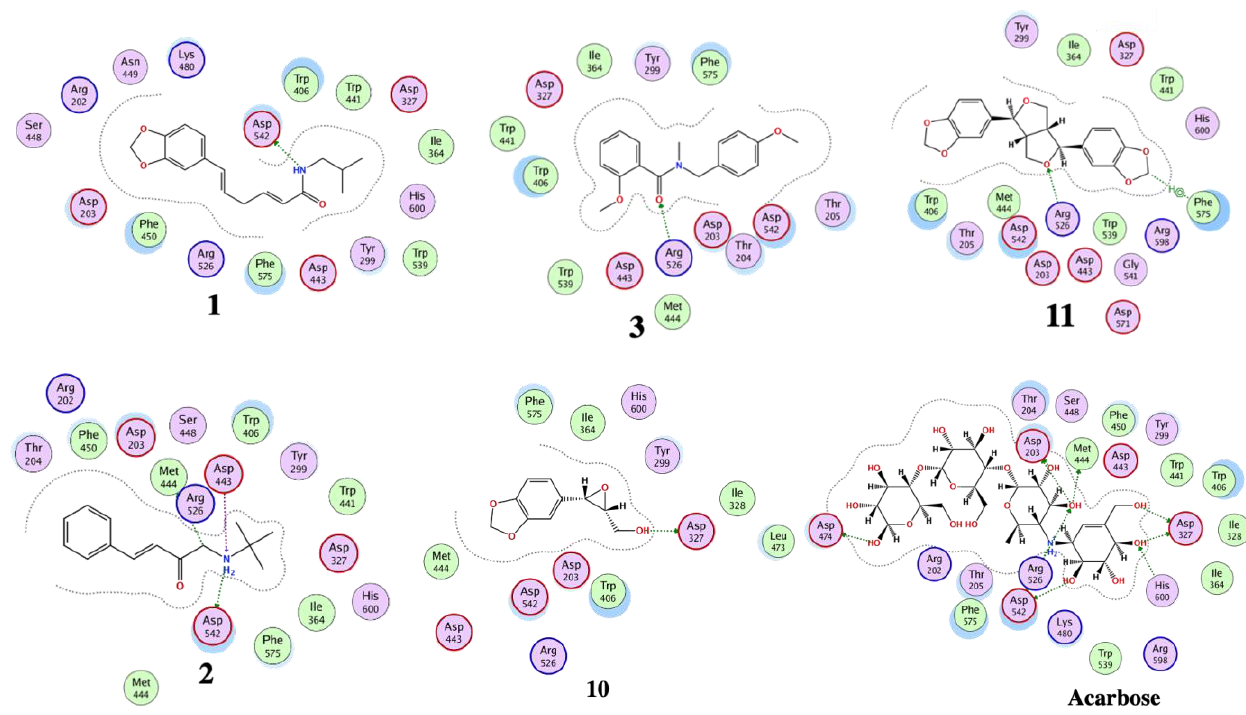
Figure 5. The 2D interactions of chaylbemide A ( 1 ), chalybeate B ( 2 ), and chalybemide C ( 3 ), 2,3- Epoxy-6,7-methylenedioxyconiferol ( 10 ), sesame ( 11 ), and the reference acarbose with α -glucosidase enzyme (PDB ID: 2QMJ).